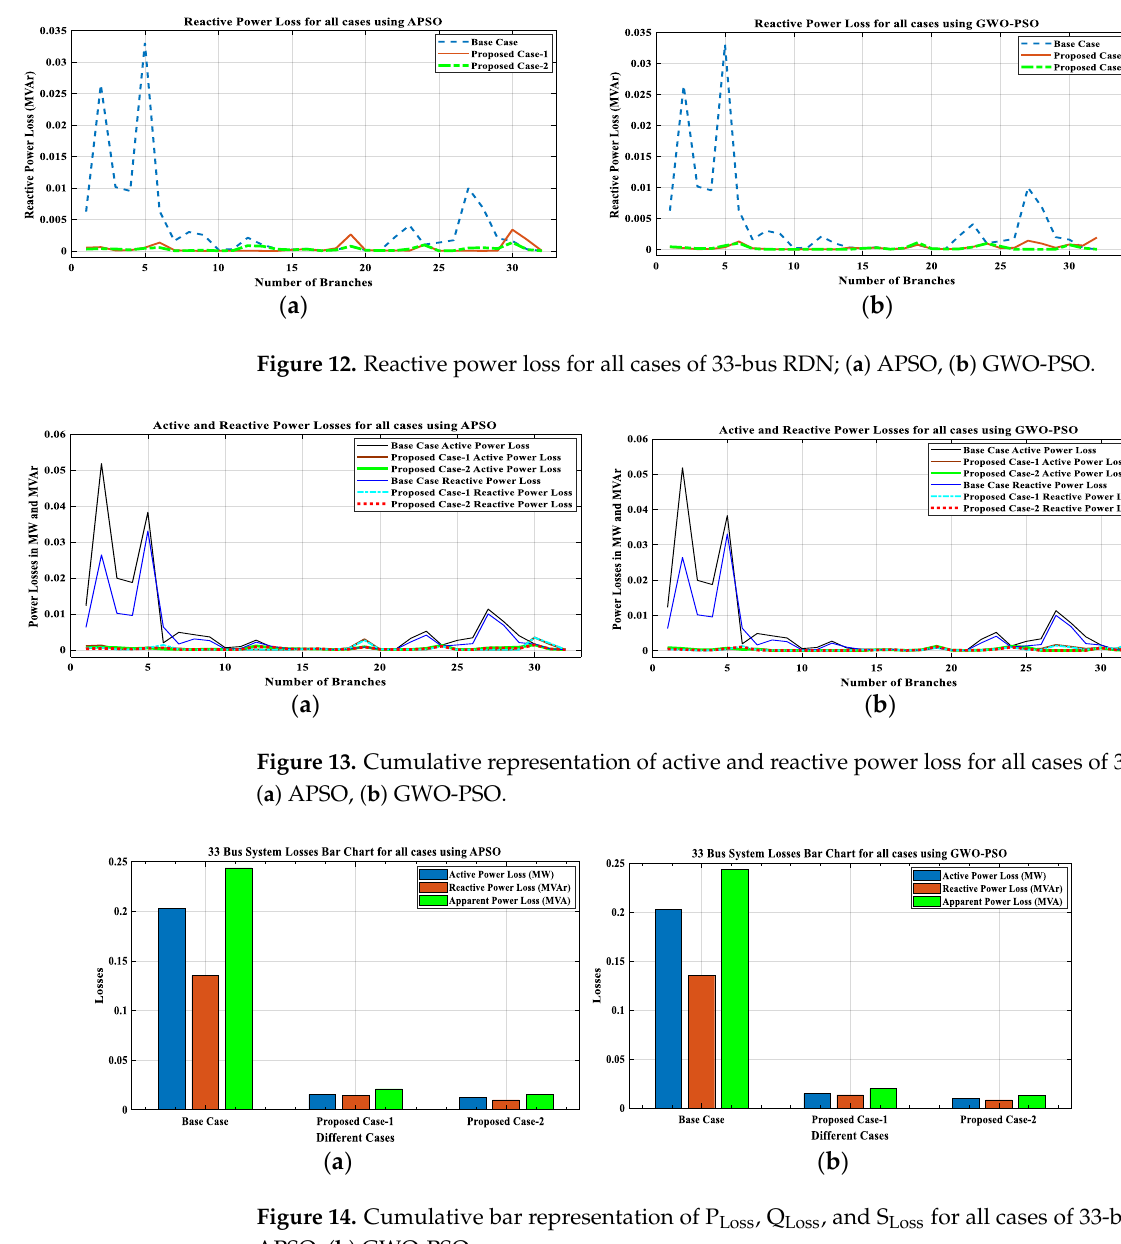
Figure 11. Real power loss for all cases of 33-bus RDN; ( a ) APSO, ( b ) GWO-PSO.